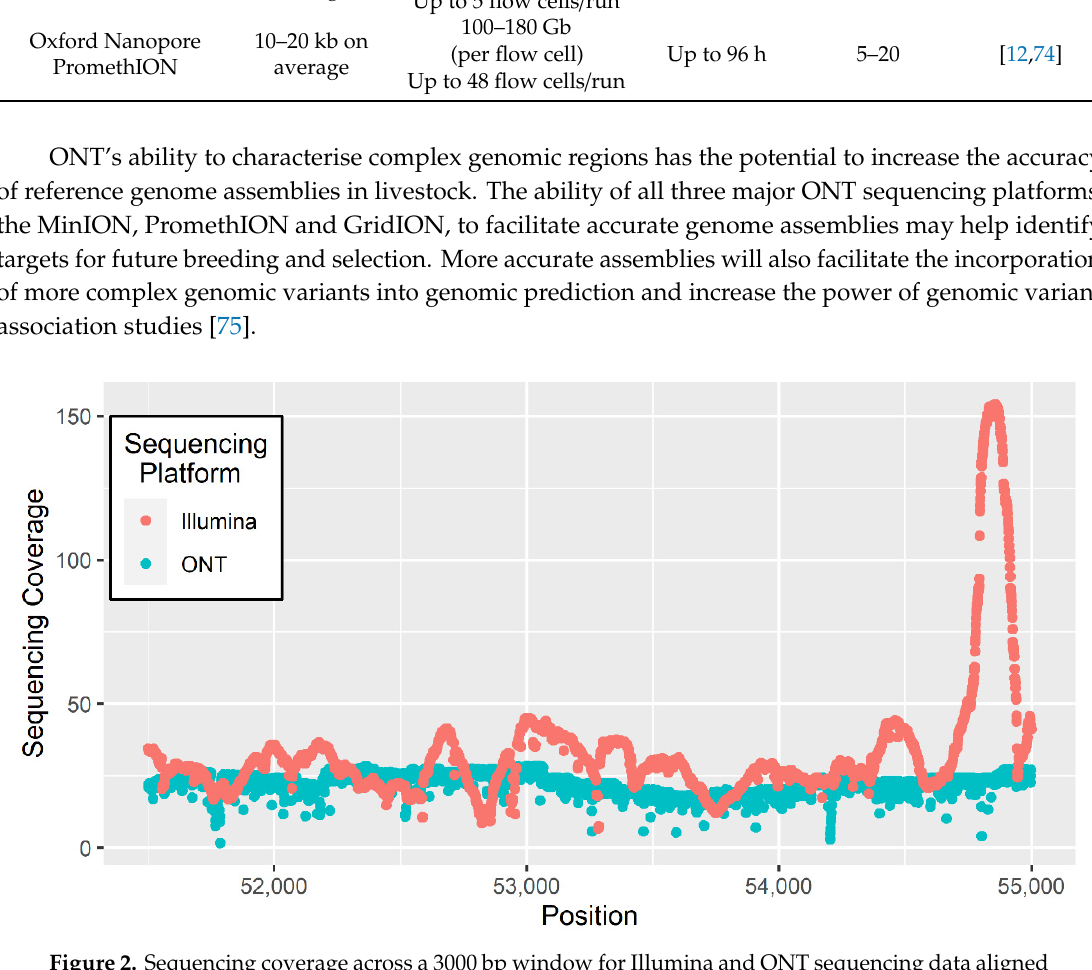
Figure 2. Sequencing coverage across a 3000 bp window for Illumina and ONT sequencing data aligned to the B. taurus reference genome [76].